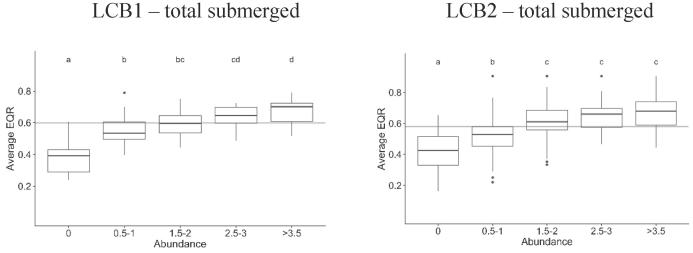
Box plot showing the relationship between EQRavg and total submerged macrophytes in LCB1 and LCB2 lakes. The horizontal line separates ‘good’ and ‘high’ status from ‘less than good’ status. Total submerged macrophyte abundance is calculated in classes ranging from 1 to 5. The macrophyte abundances can be interpreted as follows: submerged macrophyte abundance ≥1.5 – submerged macrophytes are present, at least in low-to-moderate amounts; ≥2.5 – lakes in a macrophyte-dominated state; and ≥3.5 – a high abundance of submerged macrophytes. Different letters indicate abundance classes that are statistically different (p ≤ 0.05).